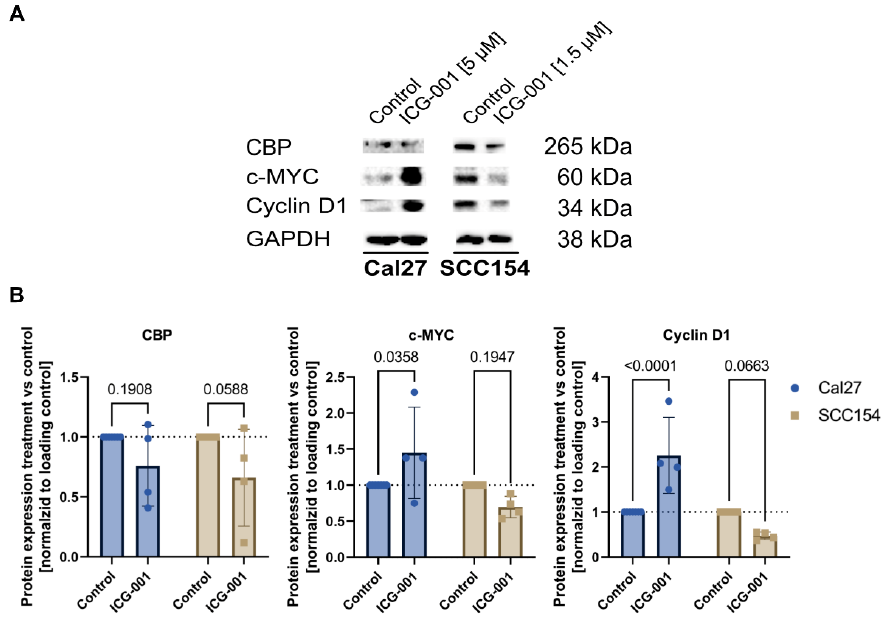
Figure 4. ICG-001 treatment leads to a downregulation of CBP and shows differential effects on WBC target genes in HPV-negative and HPV-positive HNSCC cells. ( A , B ) Representative im- munoblotting results and quantification for CBP, c-MYC, and Cyclin D1 expression in control and ICG-001-treated cells. Cells were treated with ICG-001 for 72 h. Bar plots represent mean ± SD. Sta- tistical differences between control and ICG-001-treated cells were assessed using the one-way ANOVA test. HPV; human papillomavirus, CBP; Creb-binding protein, WBC; Wnt/Beta-Catenin, SD; standard